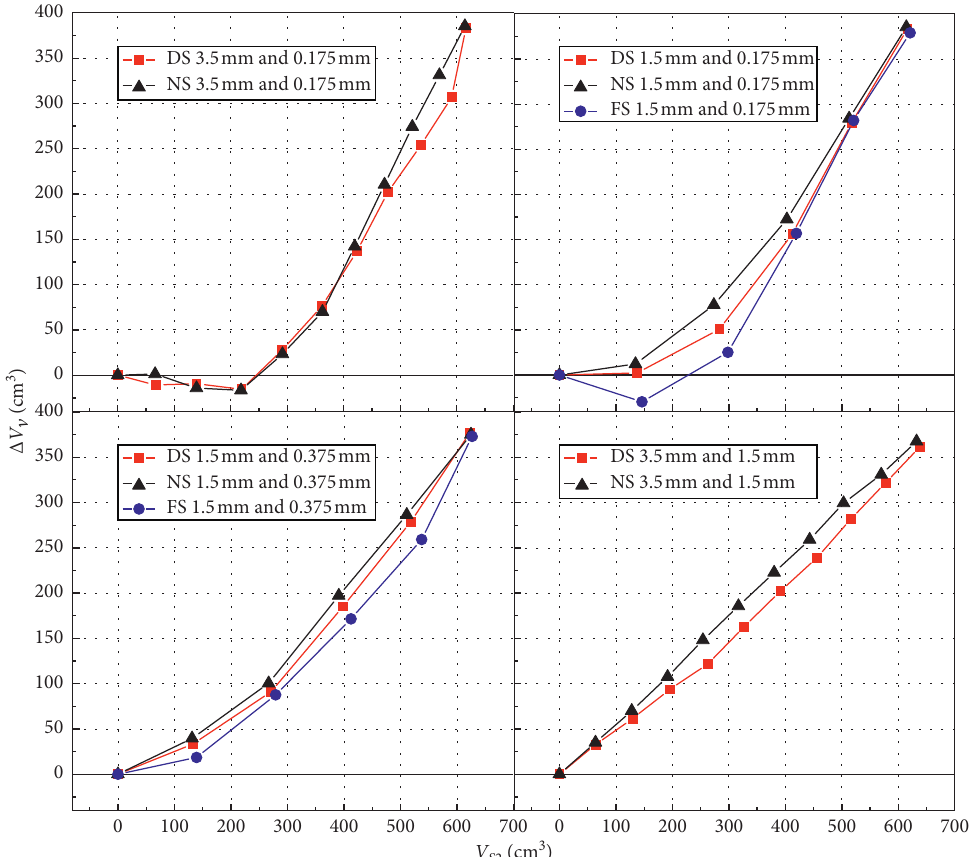
Figure 10: Comparison of Δ V